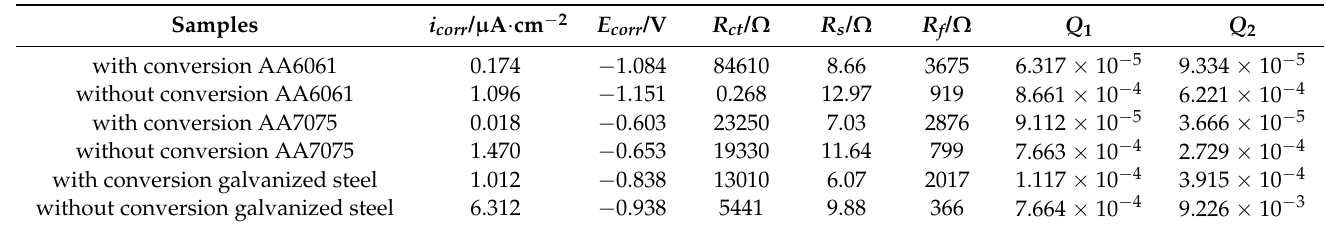
Table 1. The values of the Tafel and EEC analysis for without and with the synchronous chemical conversion of multi-metal samples.